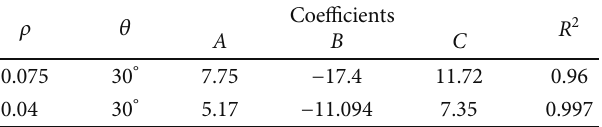
Table 4: Power law of the maximum wave height. ρ θ Coe